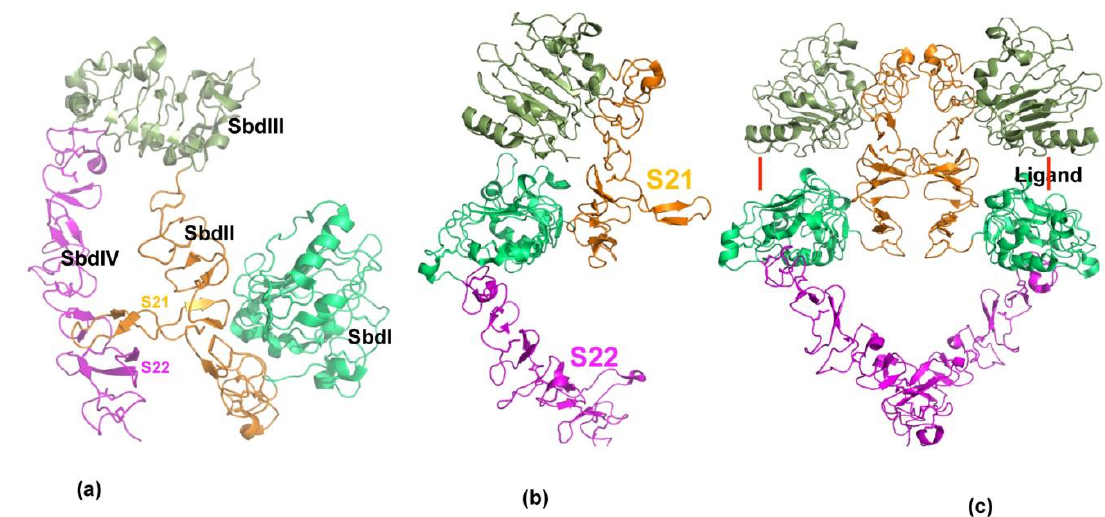
Figure 2. Structural features of erbB receptor activation. ( a ) Three-dimensional structure of ecto-domain of erbB receptor in resting state. Extracellular ErbB receptors consist of four distinct domains, SbdI–SbdIV. Each domain is shown in separate colors. In the resting state, the domains are held in closed or locked conformation through two long loops, S21 and S22 from domains SbdII and SbdIV. ( b ) Native state of Her2/neu is shown. In contrast to other members of erbB receptors, Her2 is observed only in an open or extended conformation. ( c ) Active state of erbB receptors is shown. Ligands binding to ErbB receptors induce dimer formation. Ligand binding site is shown by red line. ErbB dimers are stabilized by inter-locking loops near ligand-binding domain and at the membrane proximal (SbdIV) domains.